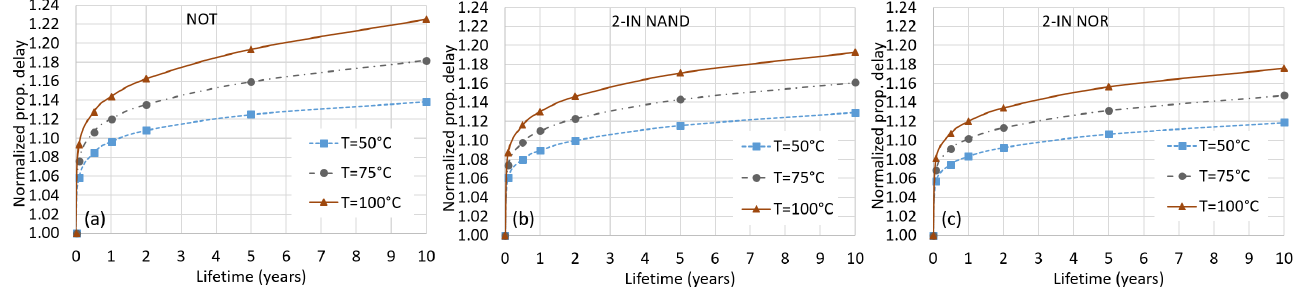
Figure 7. Normalized propagation delay for different aging temperatures for basic gates ( α = 0.5; NF : normalizing factor): ( a ) NOT ( NF = 5.00 ps); ( b ) 2-input NAND ( NF = 8.08 ps); ( c ) 2-input NOR ( NF = 11.29